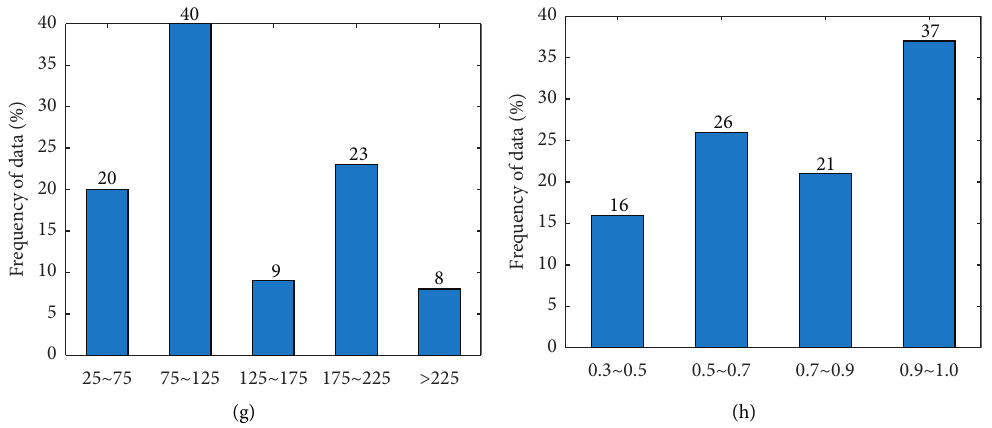
Figure 1: Range of the parameters. (a) f’c/MPa. (b) Lua/ a . (c) fy/MPa. (d) fyv/MPa. (e) ρ sv. (f) ffu/MPa. (g) Eftf/GPa.mm. (h) bf/b.